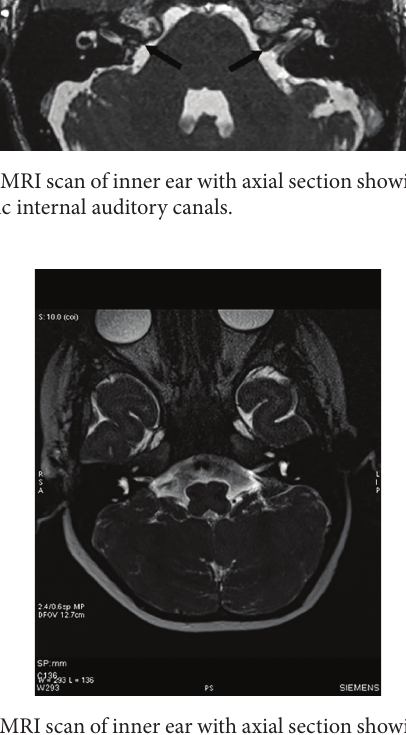
Figure 5: MRI scan of inner ear with axial section showing bilateral hypoplastic vestibulocochlear